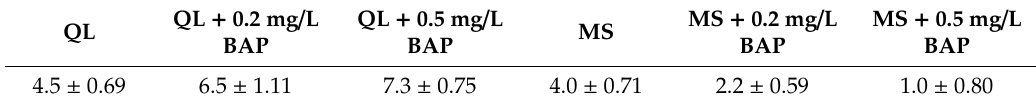
Table 4. Proliferation coe ffi cient of Hyssopus angustifolius shoots on di ff erent